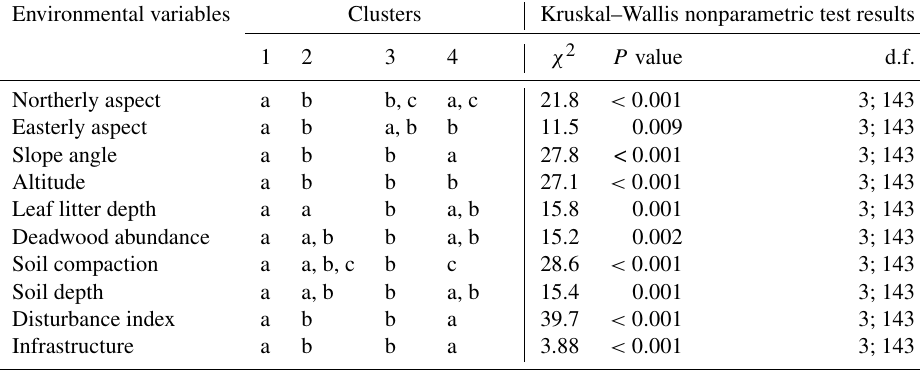
Table G1. Kruskal–Wallis nonparametric test on selected environmental variables for the four clusters of understory saplings and shrubs (subplot layer) defined by the NMDS analysis of understory in Fig. 4. Letters indicate groups that do not significantly differ within rows ( p < 0 . 05). χ 2 is chi-square; d.f. is degrees of freedom (between-group degrees of freedom and within-group degrees of